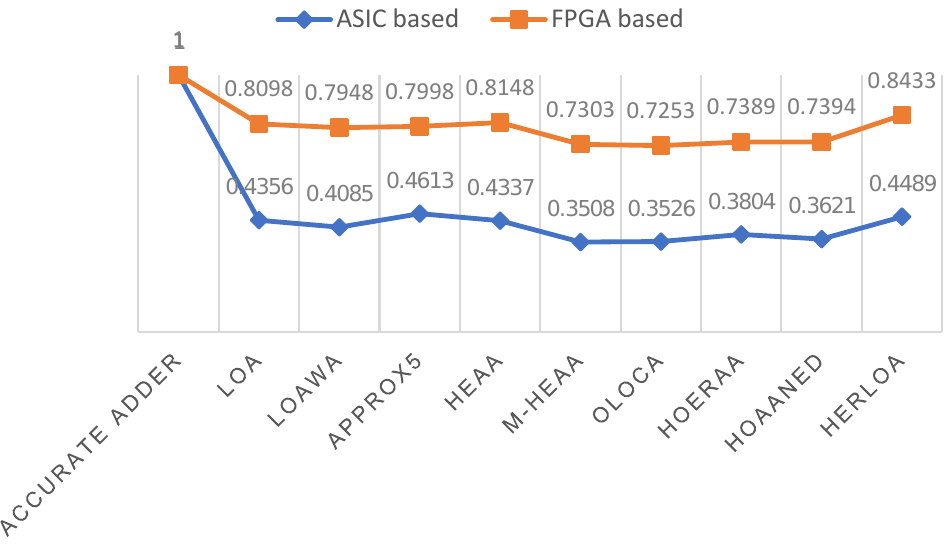
Figure 15. Normalized PDP of accurate and approximate adders corresponding to ASIC- and FPGA-based implementations.